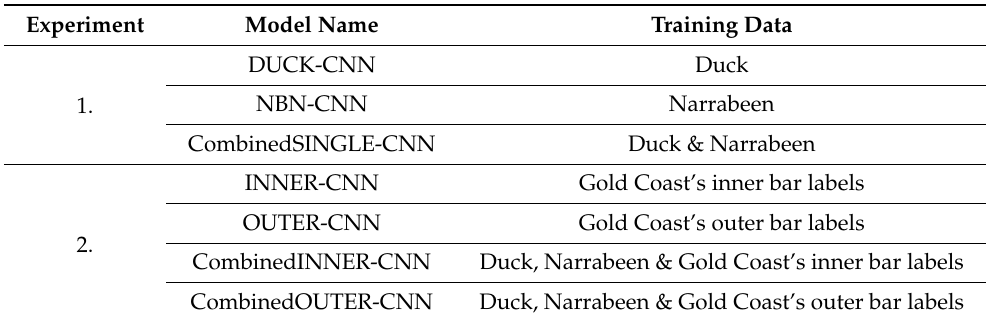
Table 4. The two experiments, the corresponding models and the data combinations used to train the models.